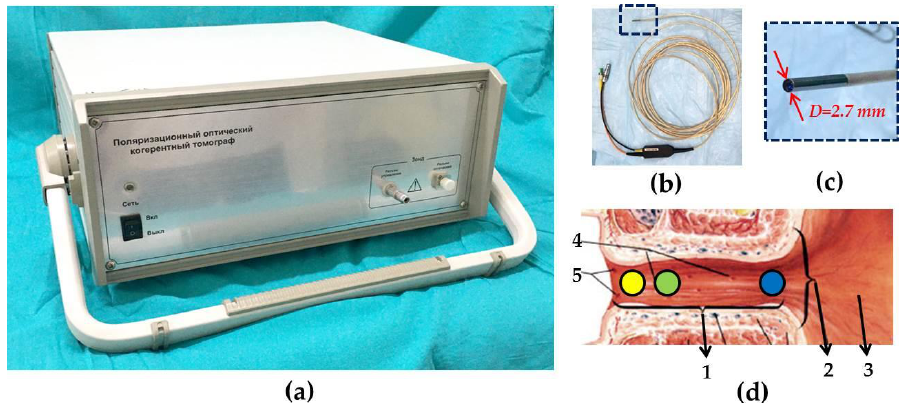
Figure 1. Cross-polarization optical tomography (CP OCT) device and areas under study shown on a diagram of the female urethra. ( a ) CP OCT device; ( b ) Flexible endoscopic forward-looking CP OCT probe; ( c ) Enlarged tip of the probe from ( b ). ( d ) Drawing of the urethra where it transitions to the bladder. Here, the circles indicate the locations from which CP OCT images were obtained in the proximal (blue), middle (green), and distal parts of the urethra (yellow) [37]. 1—urethra, 2—neck of urinary bladder, 3—triangle of urinary bladder, 4—lacunae and openings of urethral ducts, 5—openings of paraurethral Skene’s ducts. Table 2. Distribution of the CP OCT images by patient’s groups and parts of the urethra.